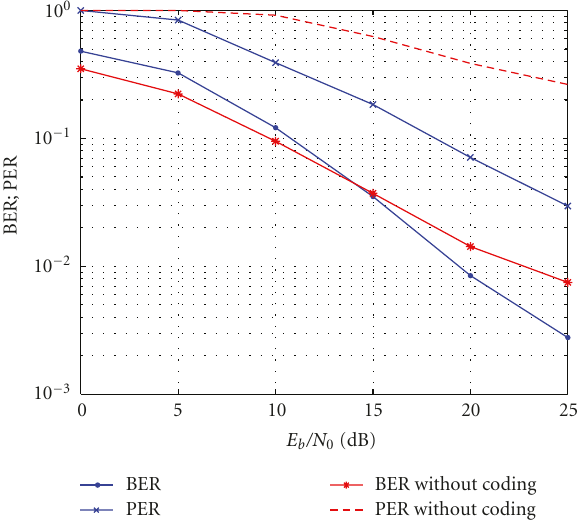
Figure 12: BER/PER when transmitting with and without coding through RTV-Expressway